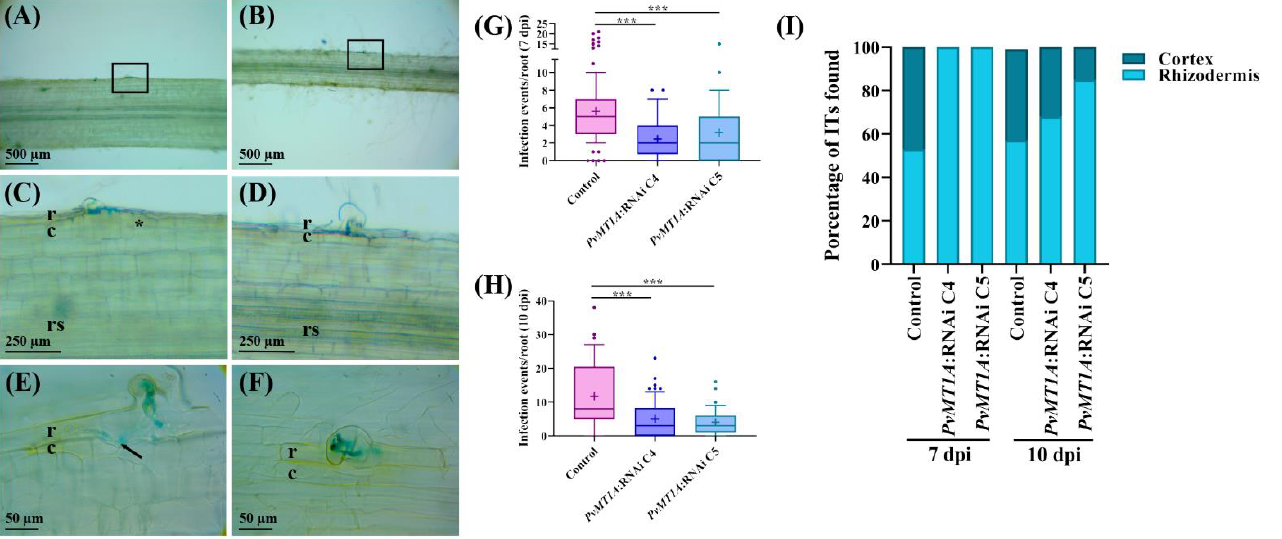
Figure 4. Analysis of infection events in control and PvMT1A -silenced transgenic roots detected by GUS staining. Representative images of infection events in control ( A ) and PvMT1A :RNAi C4 ( B ) transgenic roots inoculated at 7 dpi with R. tropici - GUS . Close-up of the marked area of panels ( A , B ) of root hair zones showing infection events in control ( C ) and PvMT1A :RNAi C4 ( D ) transgenic roots, respectively; IT of control ( E ) and PvMT1A :RNAi C4 ( F ). Cell divisions and IT invasion into cortical layers are shown with an asterisk and an arrow, respectively. The average number of total infection events was scored in control, PvMT1A :RNAi C4, and PvMT1A :RNAi C5 roots at 7 dpi ( G ) and 10 dpi ( H ) with R. tropici - GUS . The top and bottom edges of the boxes delineate the first to third quartiles, the horizontal line within the box represents the median, and the whiskers represent 10th and 90th percentiles in the data set ( n = 15). A non-parametric Kruskal–Wallis test followed by Dunn’s multiple comparisons test was performed to evaluate significant differences *** p ≤ 0.001. Percentage of IT in control and PvMT1A :RNAi observed in root hairs and cortical cells ( I ). In ( C – F ), c, cortex; r, rhizodermis, and rs: root